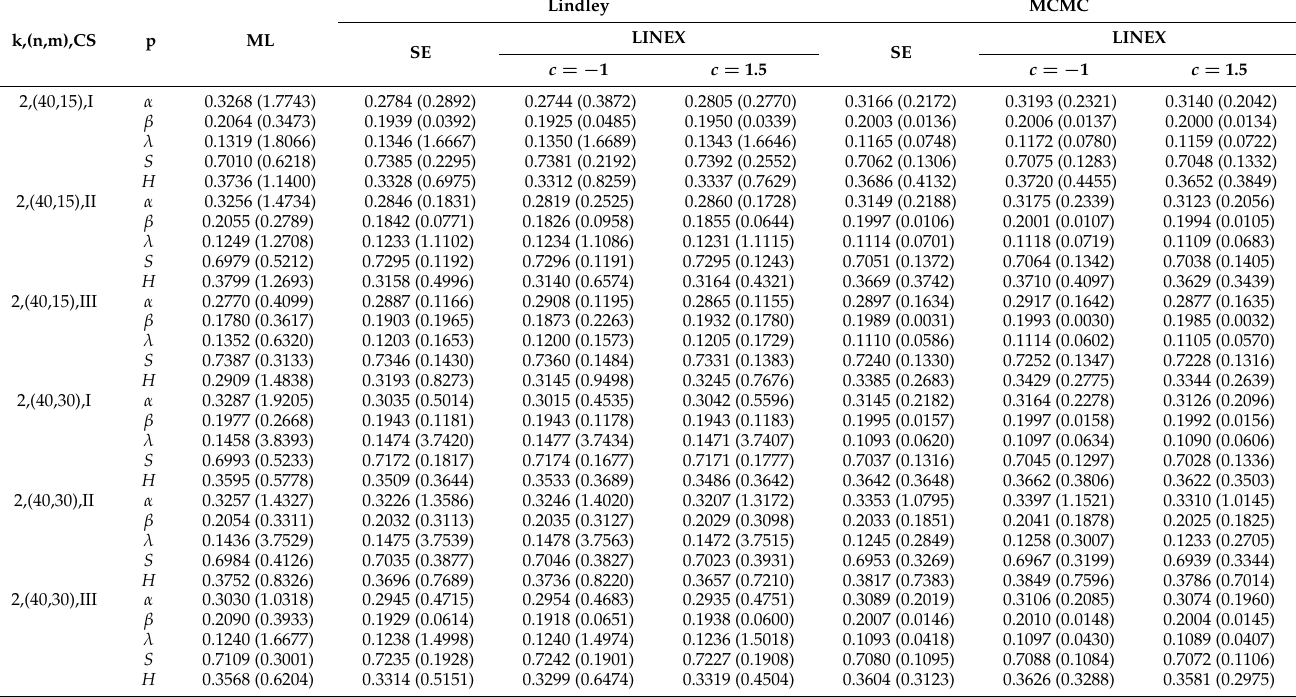
Table 1. AM and (MSE) of estimates for α , β , λ , S , and H .